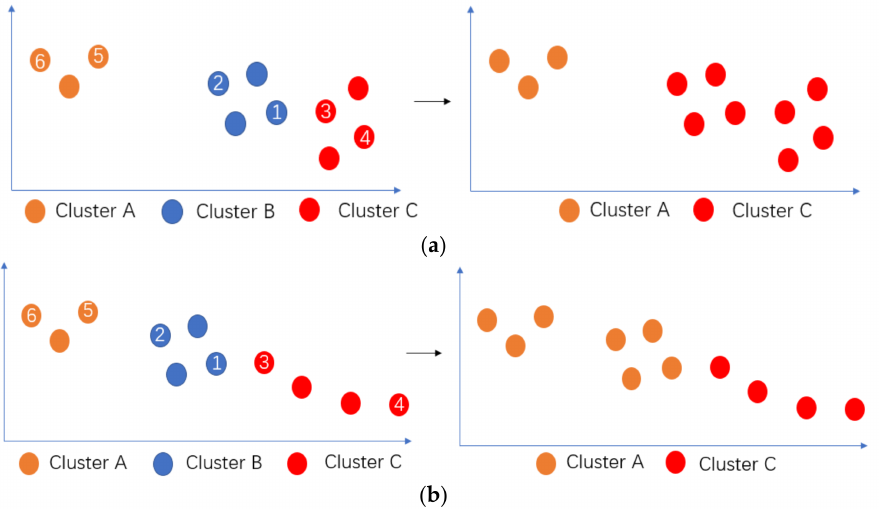
Figure 6. Examples of merging process ( a ) the process of merging Cluster B and C; ( b ) the process of merging Cluster A and B.